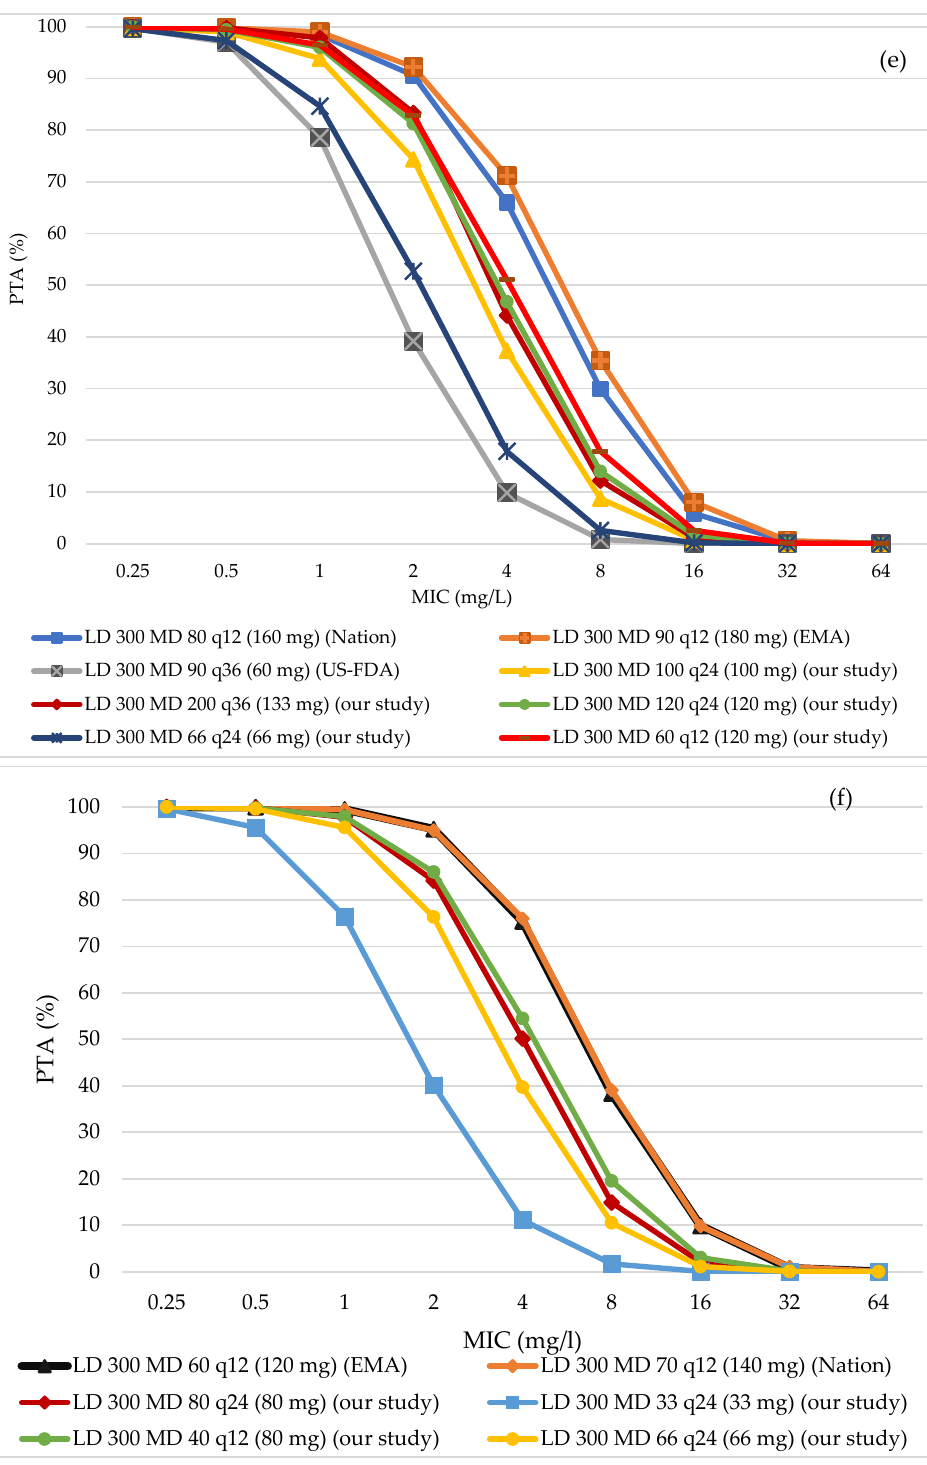
Figure 2. Probability of target attainment (PTA) achievement in the groups of CrCl 101 – 130 mL / min ( a ), 80 – 100 mL / min ( b ), 51 – 19 mL / min ( c ) , 30 – 50 mL / min ( d ), 11 – 29 mL / min ( e ), 1 – 10 mL / min ( f ). The detail of PTA results is found in Supplementary material Table S1 – 6. LD: loading dose (in mg colistin base activity), MD: maintenance dose (in colistin base activity), US-FDA: Food and Drug Administration of United State, EMA: European Medicines Agency, q12: every 12 h.